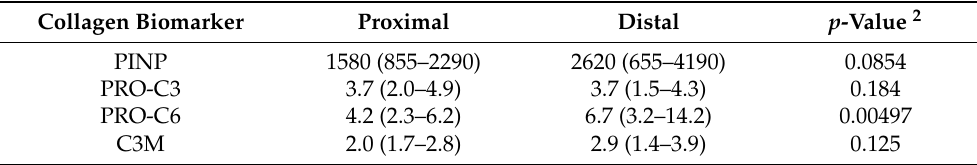
Table 1. Effect of localization on the cumulative release of PINP, PRO-C3, PRO-C6, and C3M biomarkers from fibroblasts into the media over 8 days of culture shown as ng/well 1 .